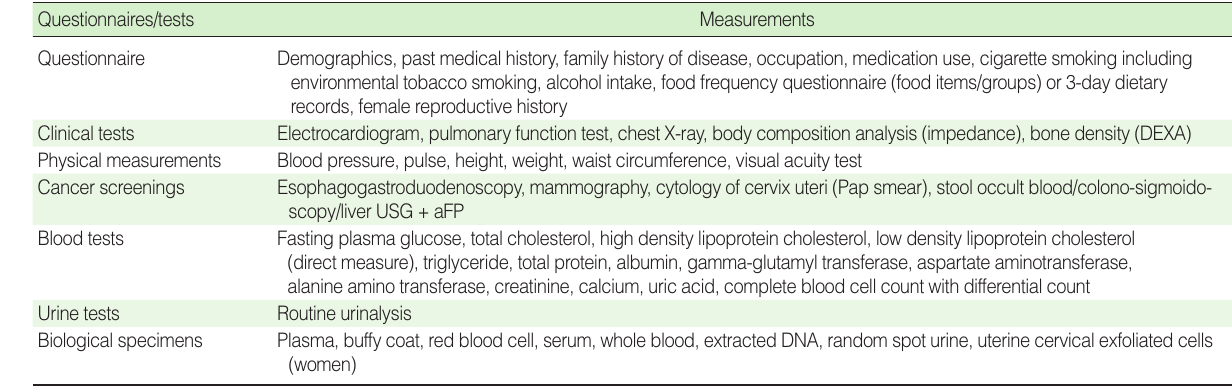
Table 2. Description of health examination tests performed on cohort participants Questionnaires/tests